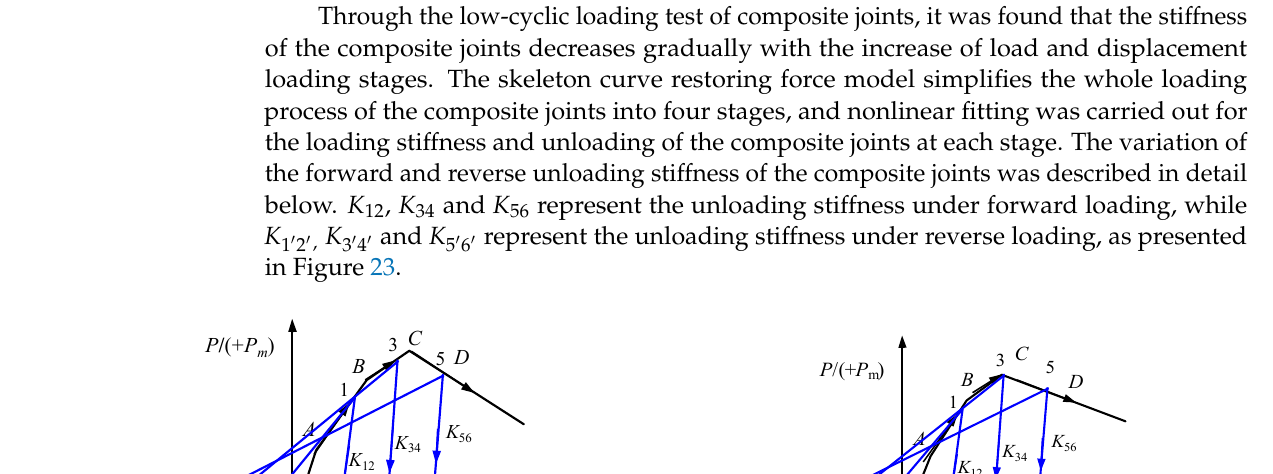
− 0.3568 Table 9. Linear equation and stiffness of each stage in skeleton curve model of exterior joint. Line Segment Regression Equation